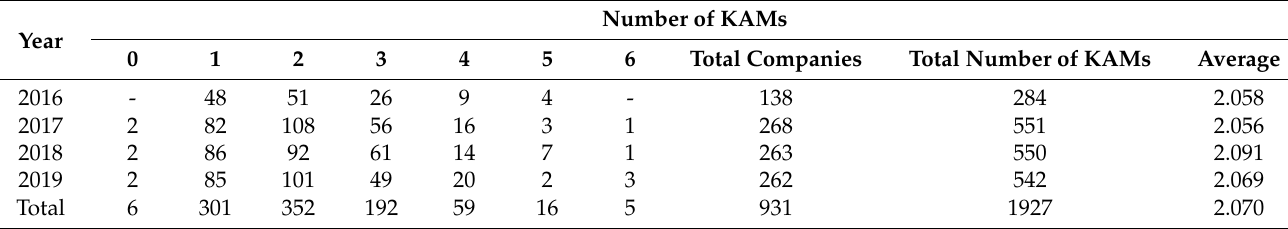
Table 4. Number of KAMs according to years of